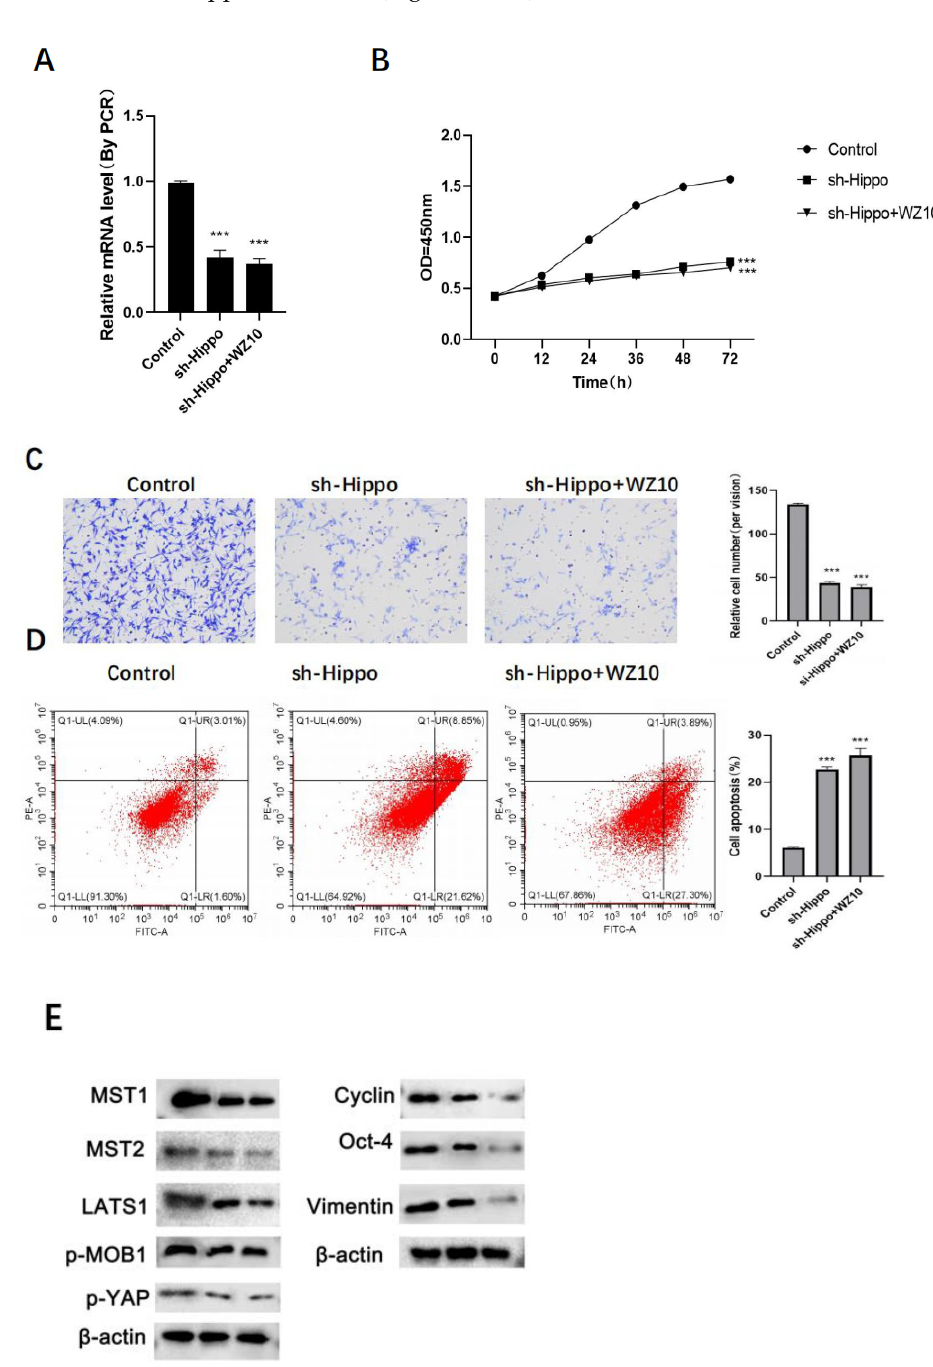
Figure 4. Mechanism of WZ10 inhibiting the activity of ovarian cancer cells. After different treatments: ( A ) the expression of Hippo was detected by RT-PCR; ( B ) detection of ovarian cancer cell proliferation activity by MTT; ( C ) detection of ovarian cancer cell invasion activity by Transwell, original image × 50; ( D ) detection of ovarian cancer cell apoptosis level by flow cytometry. Compared with control group, (E)Protein expression levels after different treatments,*** p <